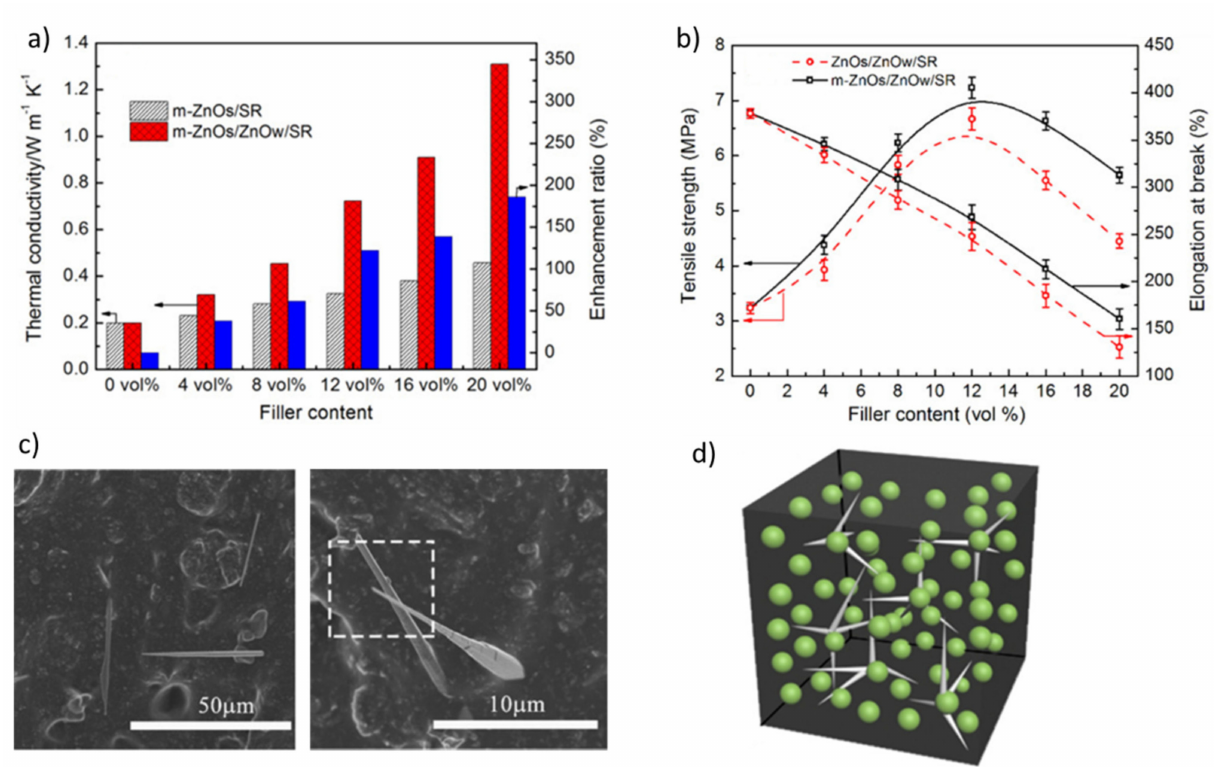
Figure 20. ( a ) Comparison of thermal conductivity between m-ZnOs/SR and m-ZnOs/ZnOw/SR nanocomposites at different filler volume fractions; ( b ) Tensile strength and elongation at break of the ZnOs/ZnOw/SR and m-ZnOs/ZnOw/SR nanocomposites; ( c ) Cross-section morphologies of the m-ZnOs/ZnOw/SR nanocomposites enclosing 8 v / v % of hybrid filler; ( d ) Schematic illustration of the thermally conducting network in the SR composite filled with m-ZnOs and m- ZnOs/ZnOw. Adapted from [203]. Copyright© 2018 Wiley Periodicals, Inc. All rights